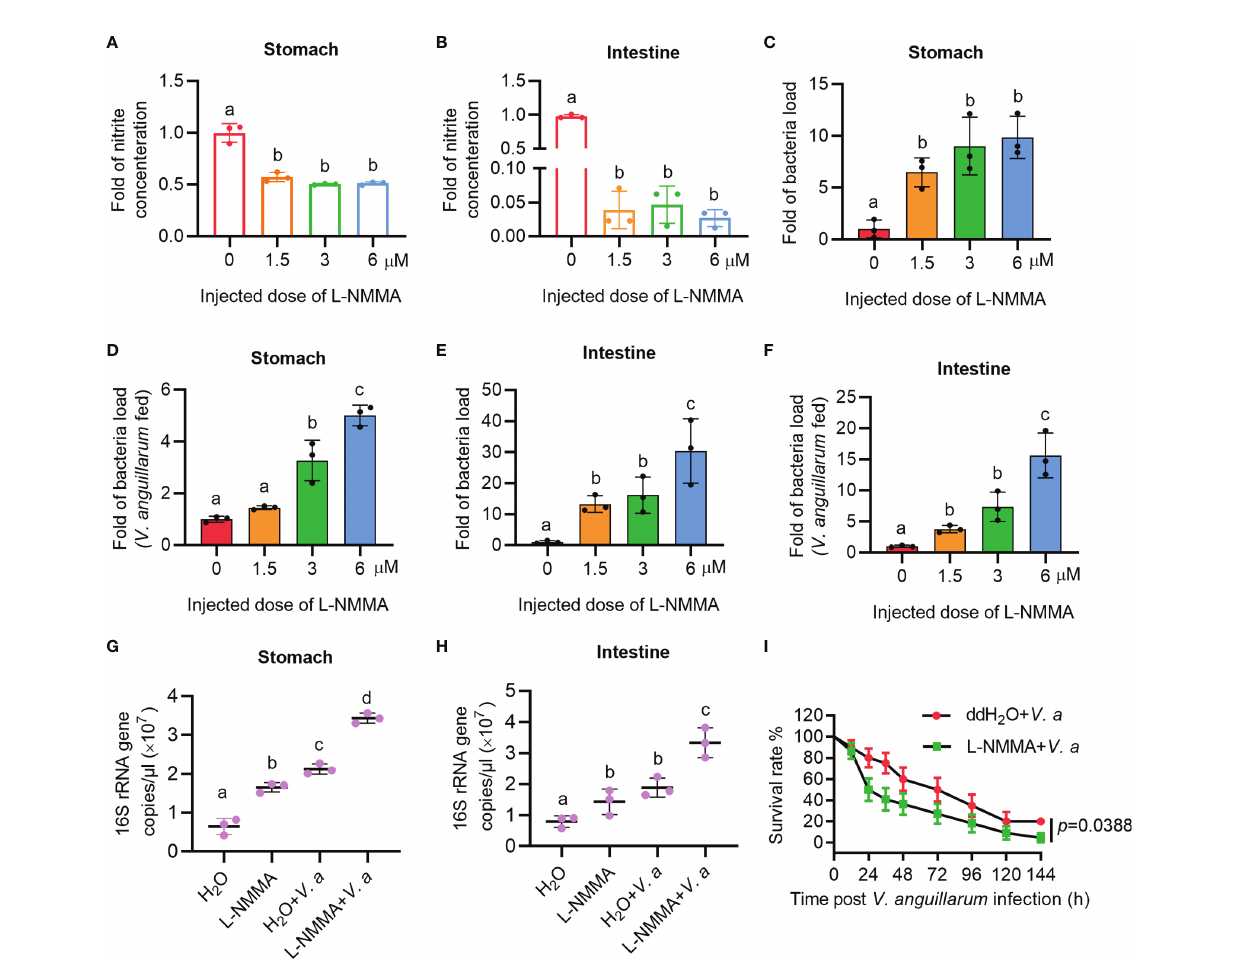
FIGURE 3 | The nitrite level decreased and the bacterial load increased in the gastrointestinal track of shrimp after L-NMMA treatment. (A, B) Nitrite level in the stomach (A) and intestines (B) of L-NMMA-treated shrimp without bacterial infection, analyzed using the Gress Reagent colorimetric method. (C) The bacterial load in the stomach of L-NMMA-treated shrimp without bacterial infection. (D) The bacterial load in the stomach of L-NMMA- and V. anguillarum cotreated shrimp. (E) The bacterial load in the intestines of L-NMMA-treated shrimp without bacterial infection. (F) The bacterial load in the intestines of L-NMMA- and V. anguillarum cotreated shrimp. (G) The 16S rRNA gene copies in the stomach of shrimp injected with 3 m M L-NMMA before and after V. anguillarum infection. (H) The 16S rRNA gene copies in the intestines of shrimp injected with 3 m M L-NMMA before and after V. anguillarum infection. (I) Survival rate of shrimp injected with 3 m M L-NMMA following V. anguillarum infection; ddH 2 O + V. anguillarum- injected shrimp were used as the control. One-way ANOVA was used for multiple comparisons, the different lowercase letters indicate signi fi cant differences ( p < 0.05) in the ANOVA